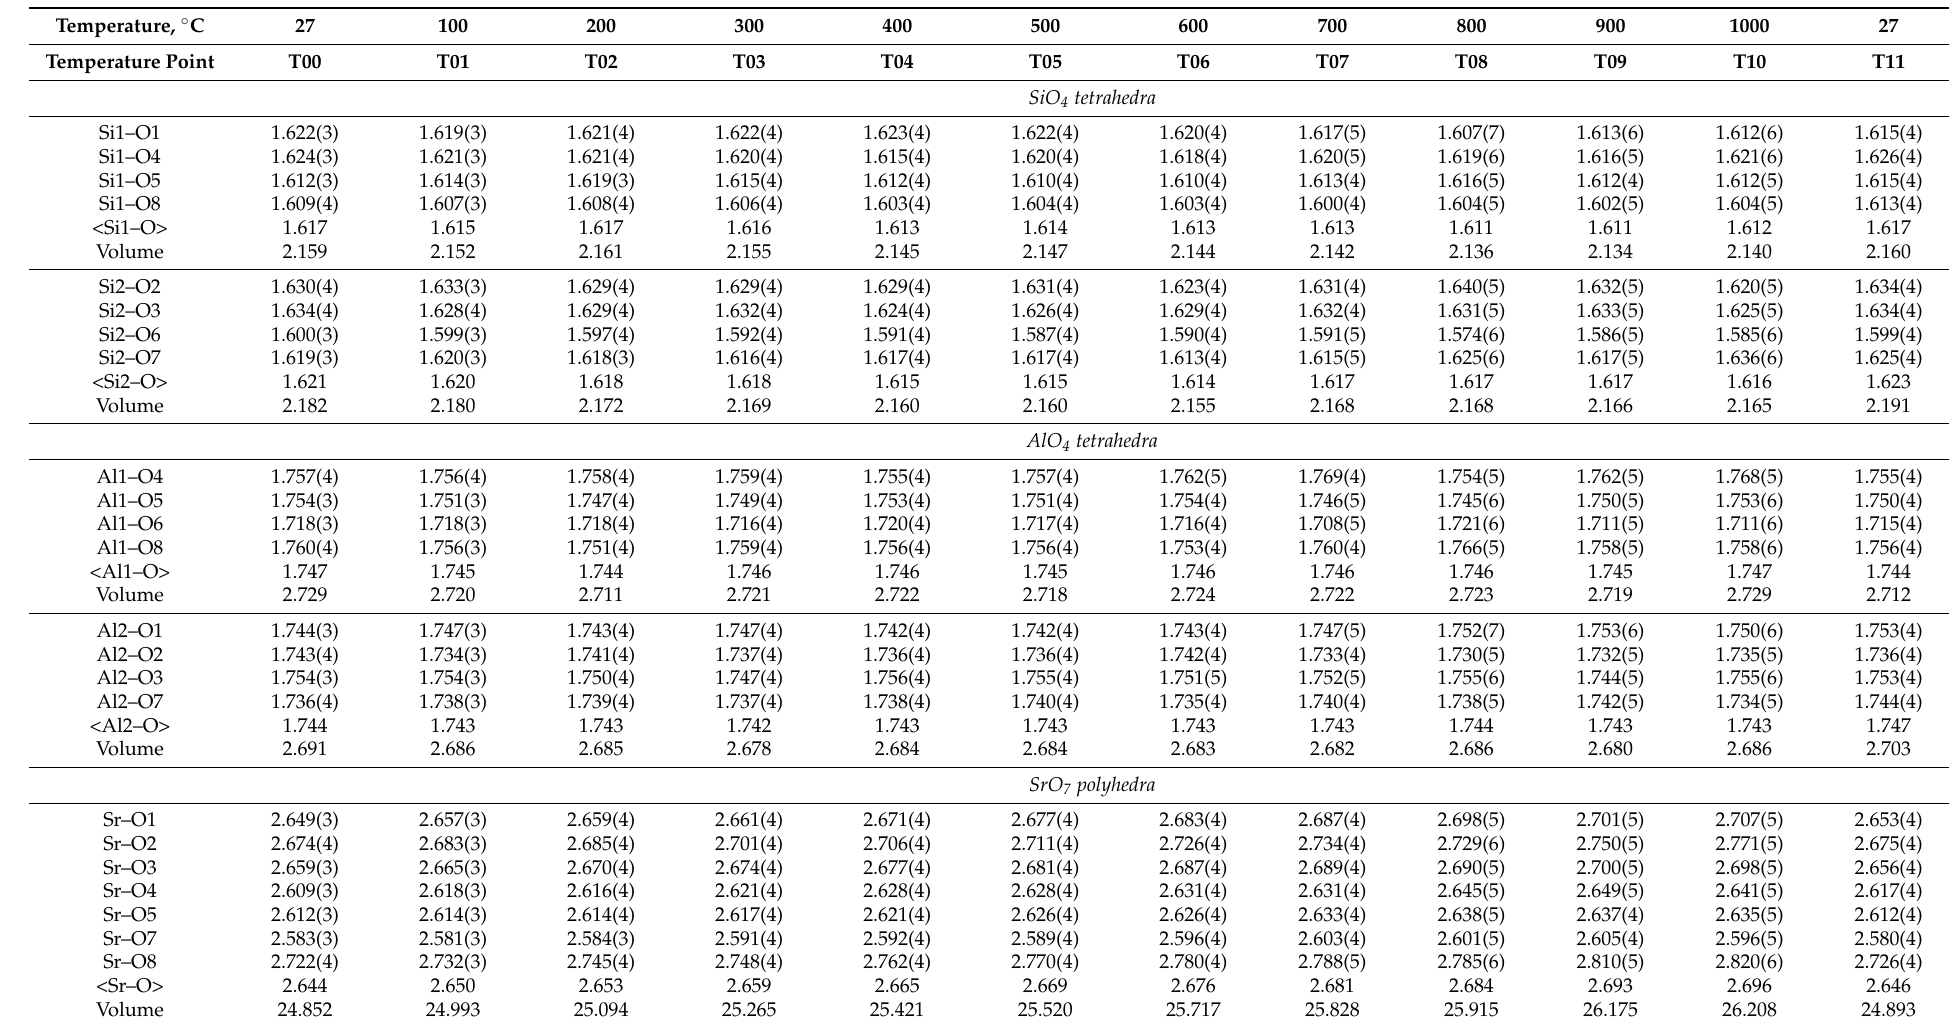
Table 3. Bond distances and polyhedral parameters in slawsonite SrAl 2 Si 2 O 8 at different temperatures in the P 2 1 / c space